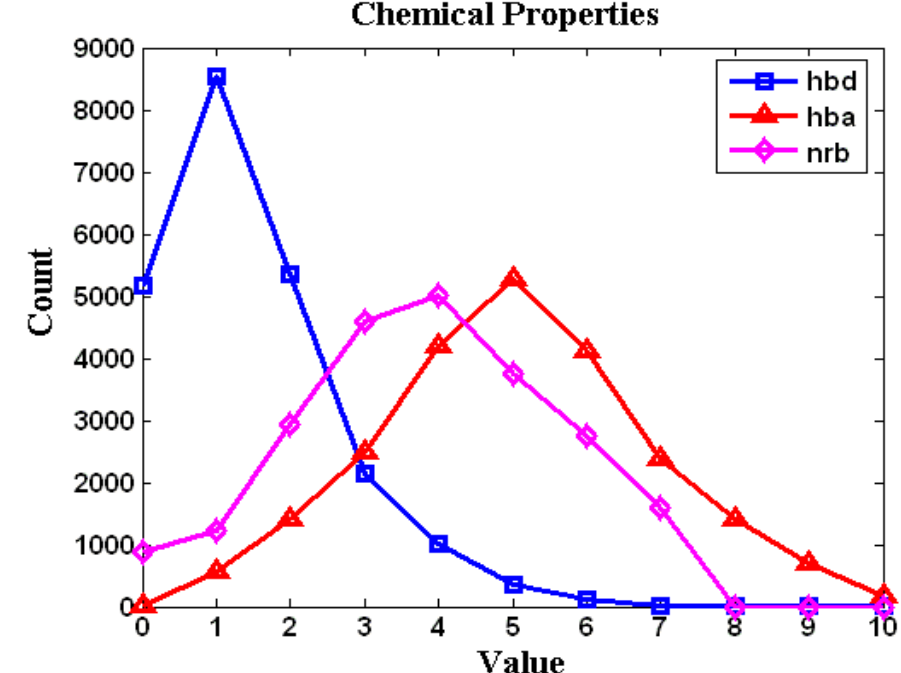
Figure 3. Histogram of some molecular descriptors calculated during screening of the Ligand database (hbd – H-bond donors, hba – H-bond acceptors, nrb – number of rotatable bonds).